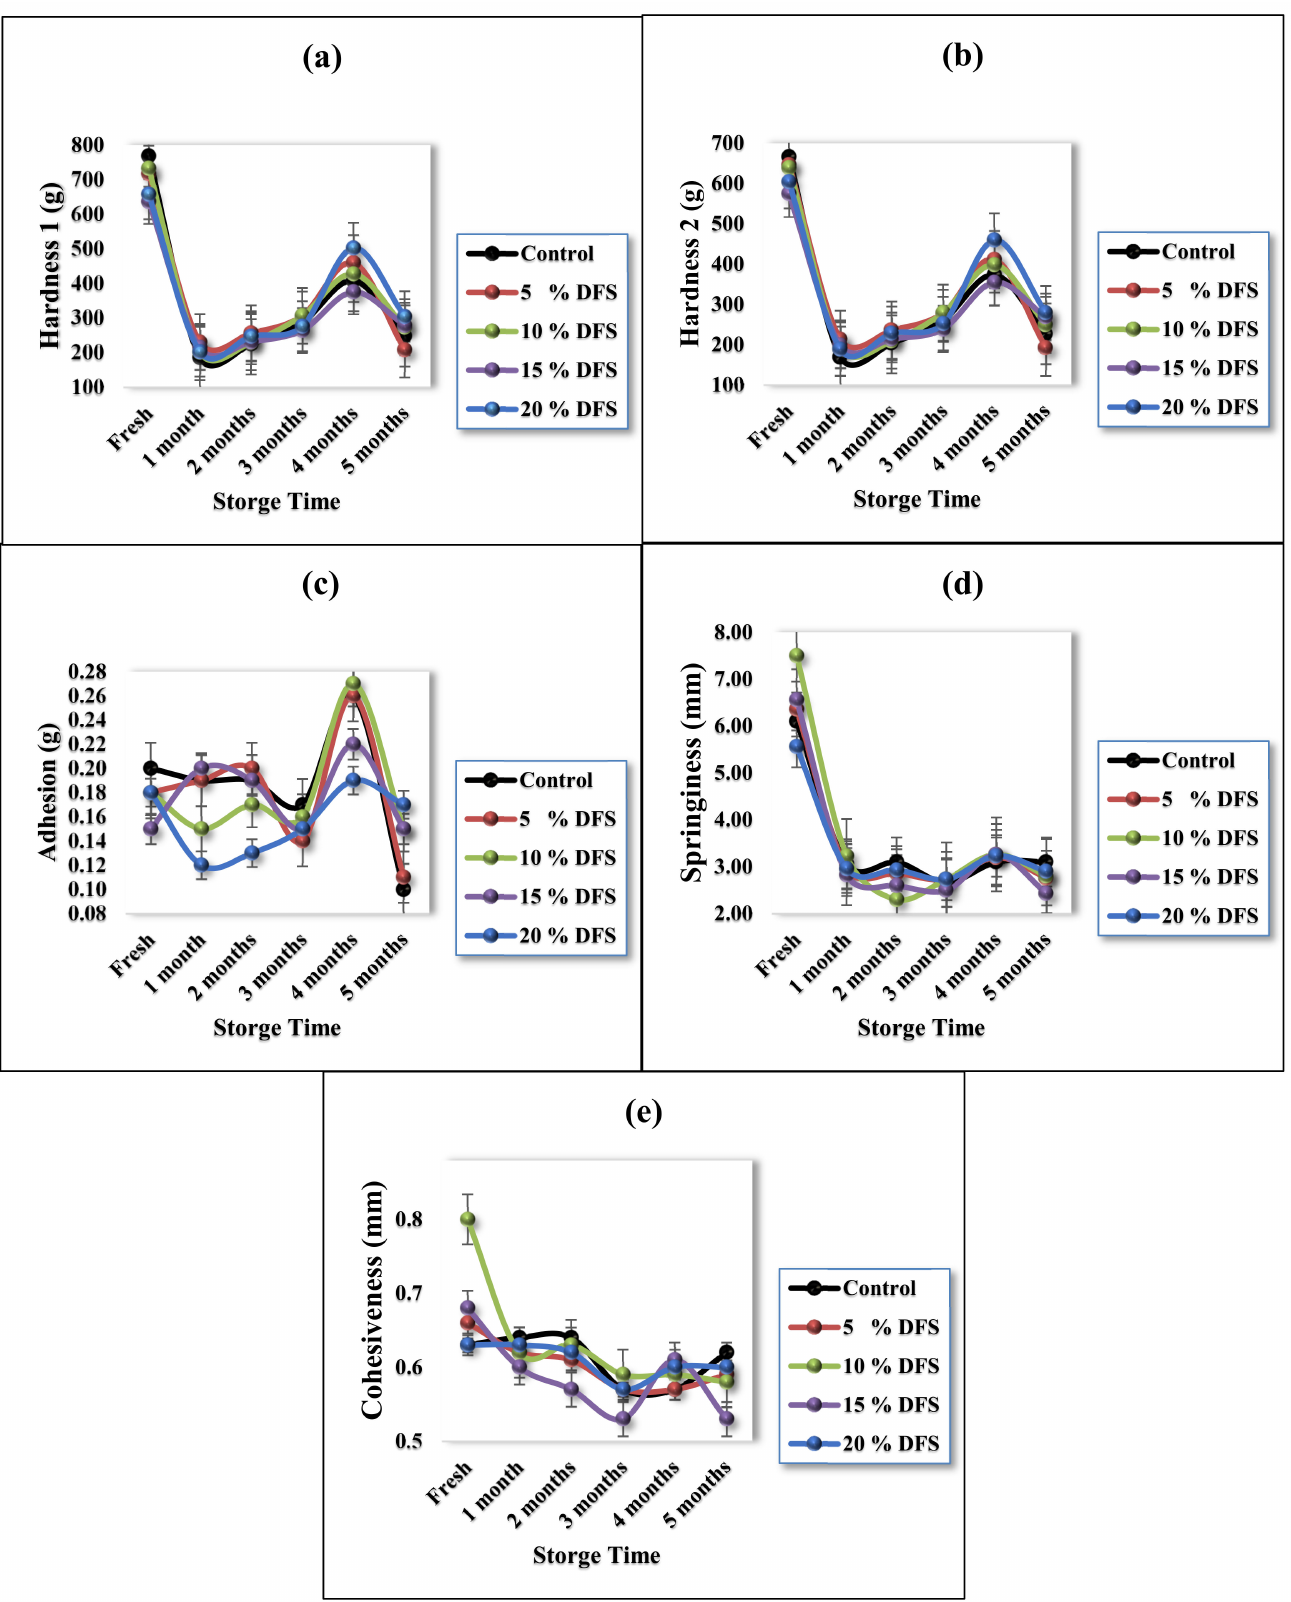
Figure 4. ( a – e ) Texture profile analysis of processed cheese with various ratios of DFS as a partial substitution for butter, in hardness 1, hardness 2, adhesion, springiness, and